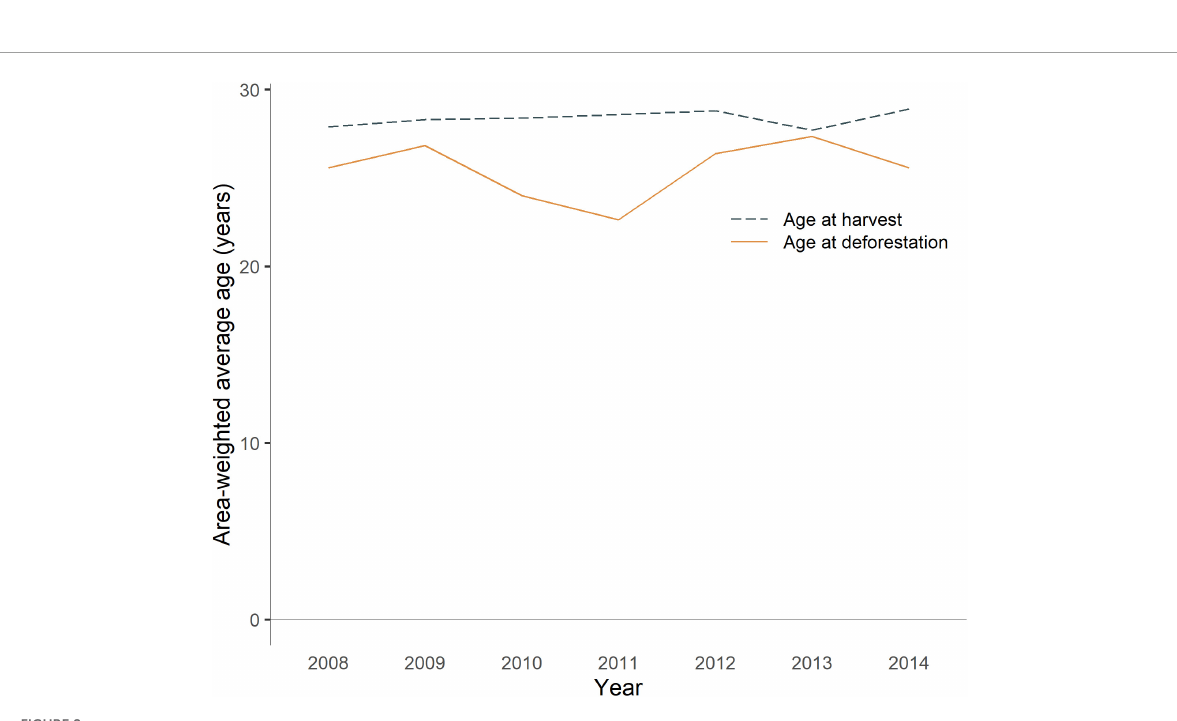
FIGURE8 Area-weighted average age of forest at time of deforestation (for pre-1990 forest land) or harvest of Pinus radiata for all forest land, i.e., both pre-1990 and post-1989 forest land. Data from MAF et al. (2009, 2010, 2011), MPI et al. (2012, 2013, 2014, 2016, 2017, 2019, 2021), and MPI